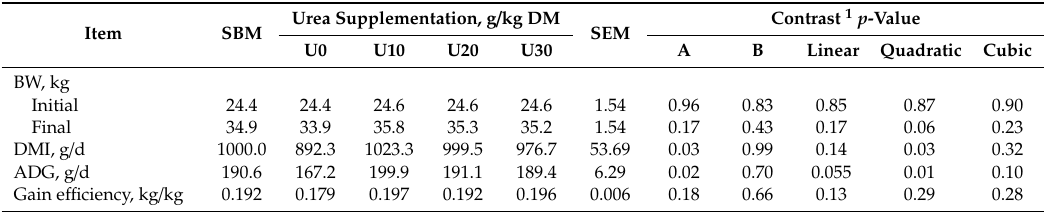
Table 5. E ff ects of urea supplementation on body weight, dry matter intake, average daily gain, and gain e ffi ciency in fatting